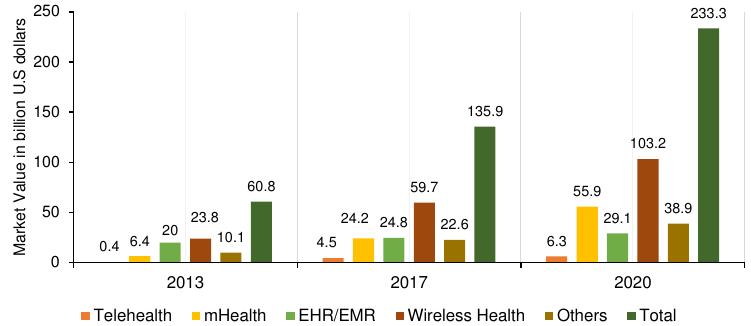
Figure 9. Global digital health market from 2013–2020, by segment (in billion U.S. dollars) (source: GSMA